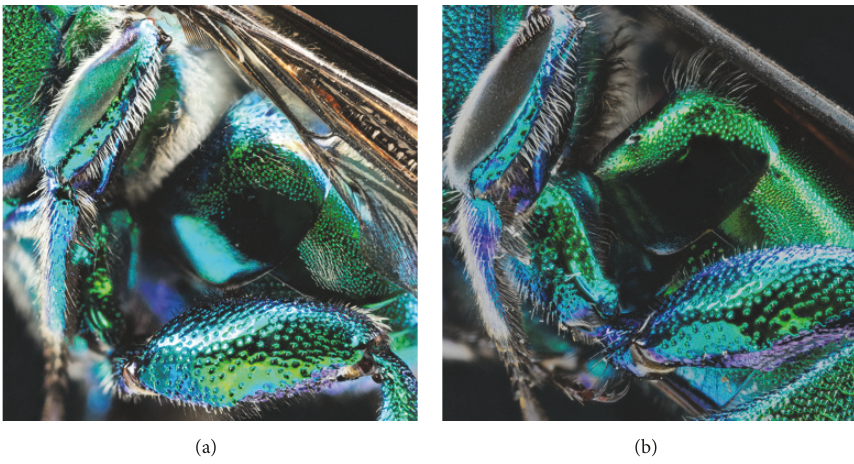
Figure 8: Male legs of parasitic euglossines: (a) E. lepeletieri; (b) E. smaragdina .